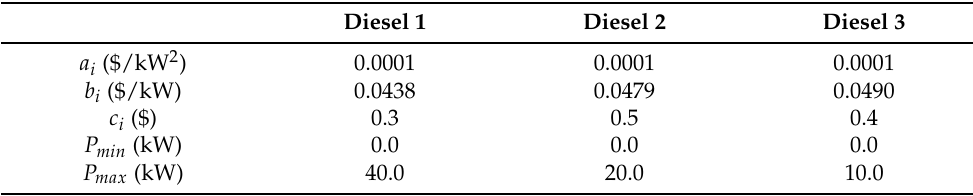
Table 1. Generator parameters.